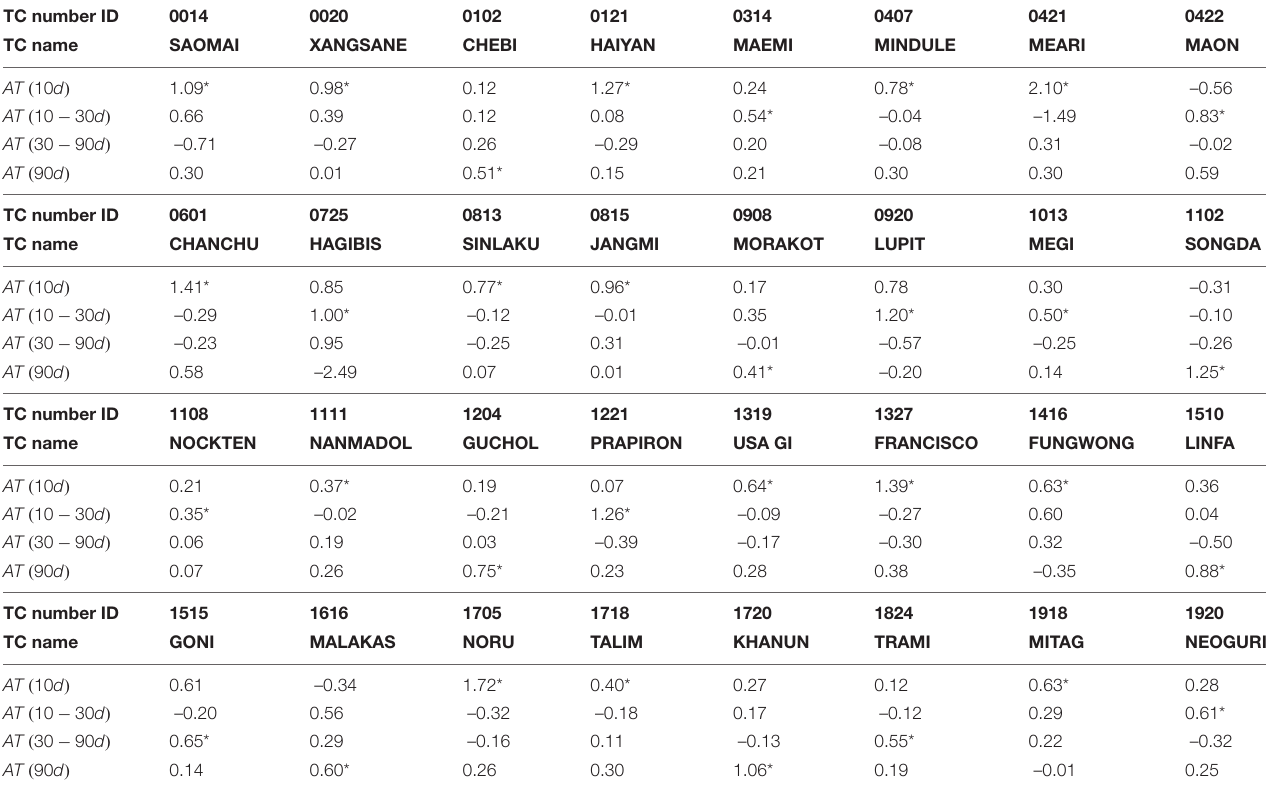
TABLE 3 | The mean AT value for the SRT cases associated with each wave mode averaging within the sudden track